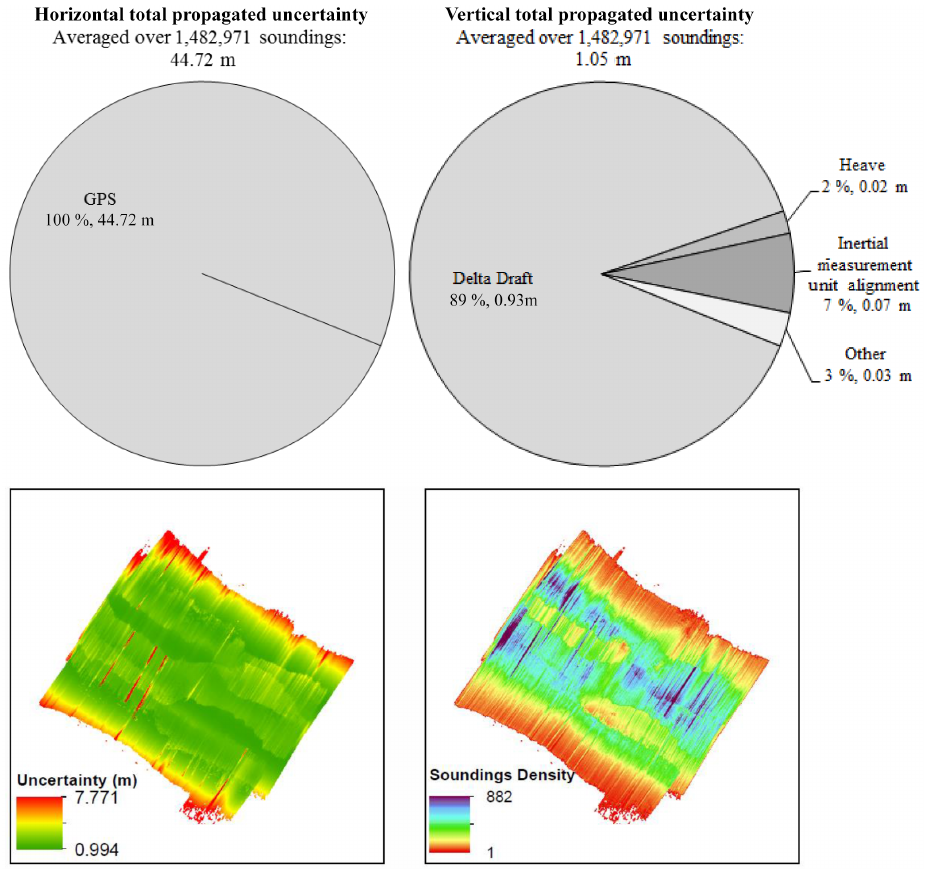
Figure 3. Example of elements that can be extracted and visualized when using the CUBE algorithm, using the ROV-based data set from Fig. 4 (source: Lecours and Devillers, 2015). In the top panel, the components contributing to the horizontal and vertical TPUs can be studied. Other marginal contributions to the vertical TPU included the roll and pitch of the platform, timing of the inertial measurement unit, and uncertainty associated with the sonar system (range and angle). The combination of the GPS and delta draft provides the three-dimensional position of the soundings ( x , y , z ); in ROV-based research, the positional accuracy decreases with depth (Lecours and Devillers, 2015). In the bottom panel, it is possible to visualize how the uncertainty and the density of soundings vary